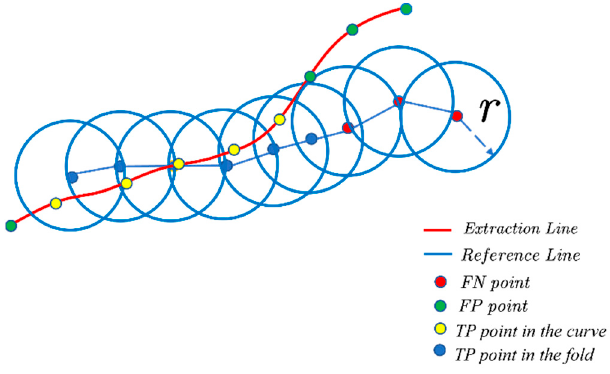
Figure 10. Line-feature-accuracy comparison method.